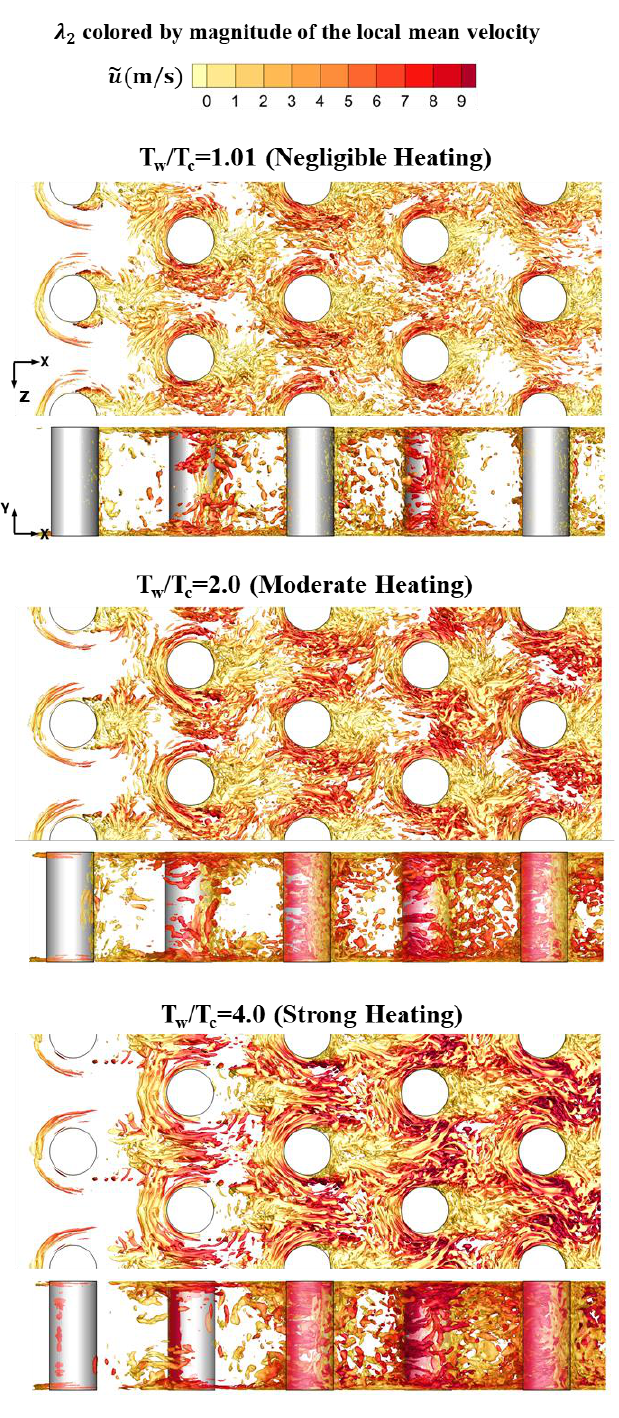
Figure 11. 𝜆 2 -criterion colored by magnitude of mean velocity. Figure 11. λ 2 -criterion colored by magnitude of mean